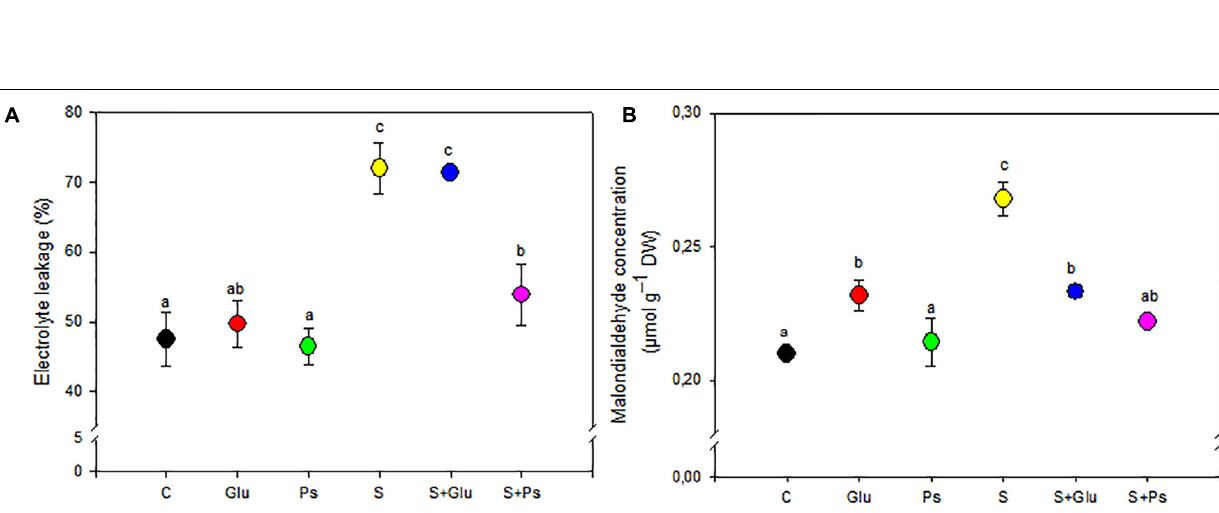
FIGURE 3 | Effect of bacterial inoculation on EL (A) and MDA (B) content of S. fruticosa shoots, in the absence (0 mM NaCl) and in the presence of NaCl (600 mM NaCl). Values are the means standard deviation of five replicates. Values sharing the different letters indicate significant differences between treatments at the 5% level